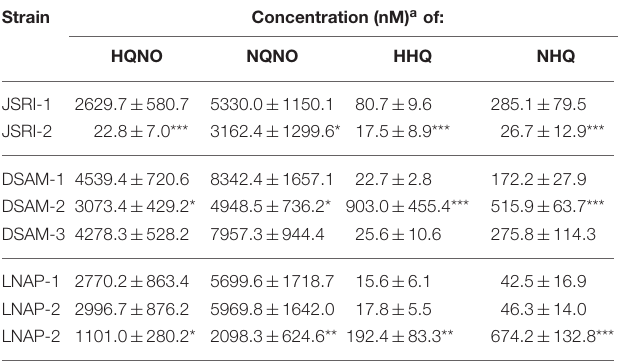
TABLE 2 | Quantification of AQ metabolites in CF isolates. Strain